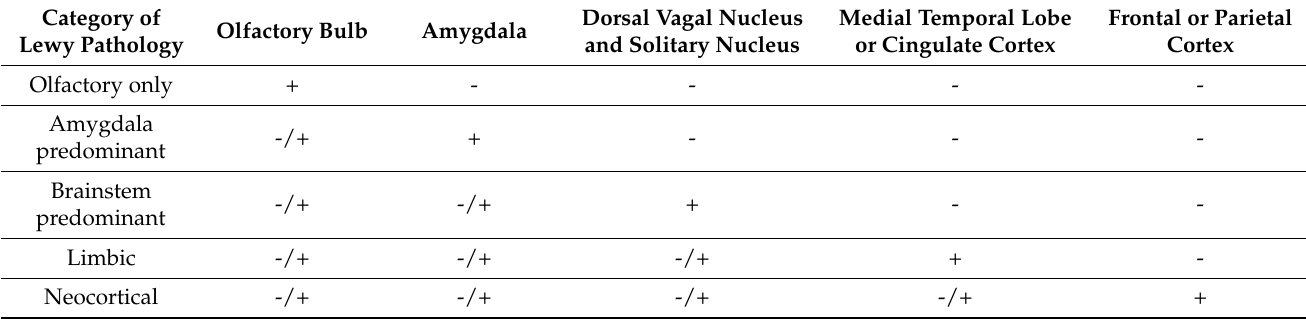
Table 1. Consensus criteria for the diagnosis of Lewy disease according to the LPC